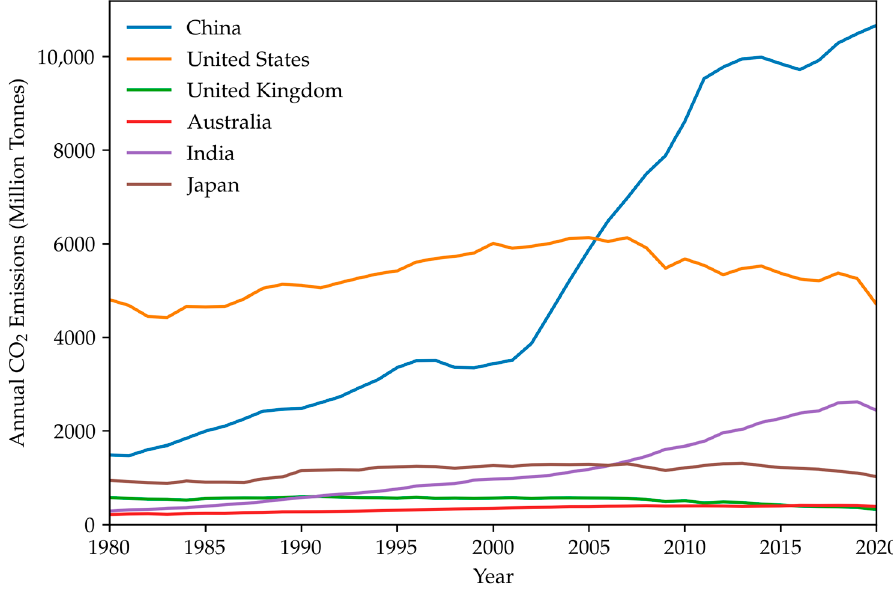
Figure 1. Annual CO 2 emissions of some countries from 1980 to 2020 [55]. Data were derived from the Global Carbon Project.